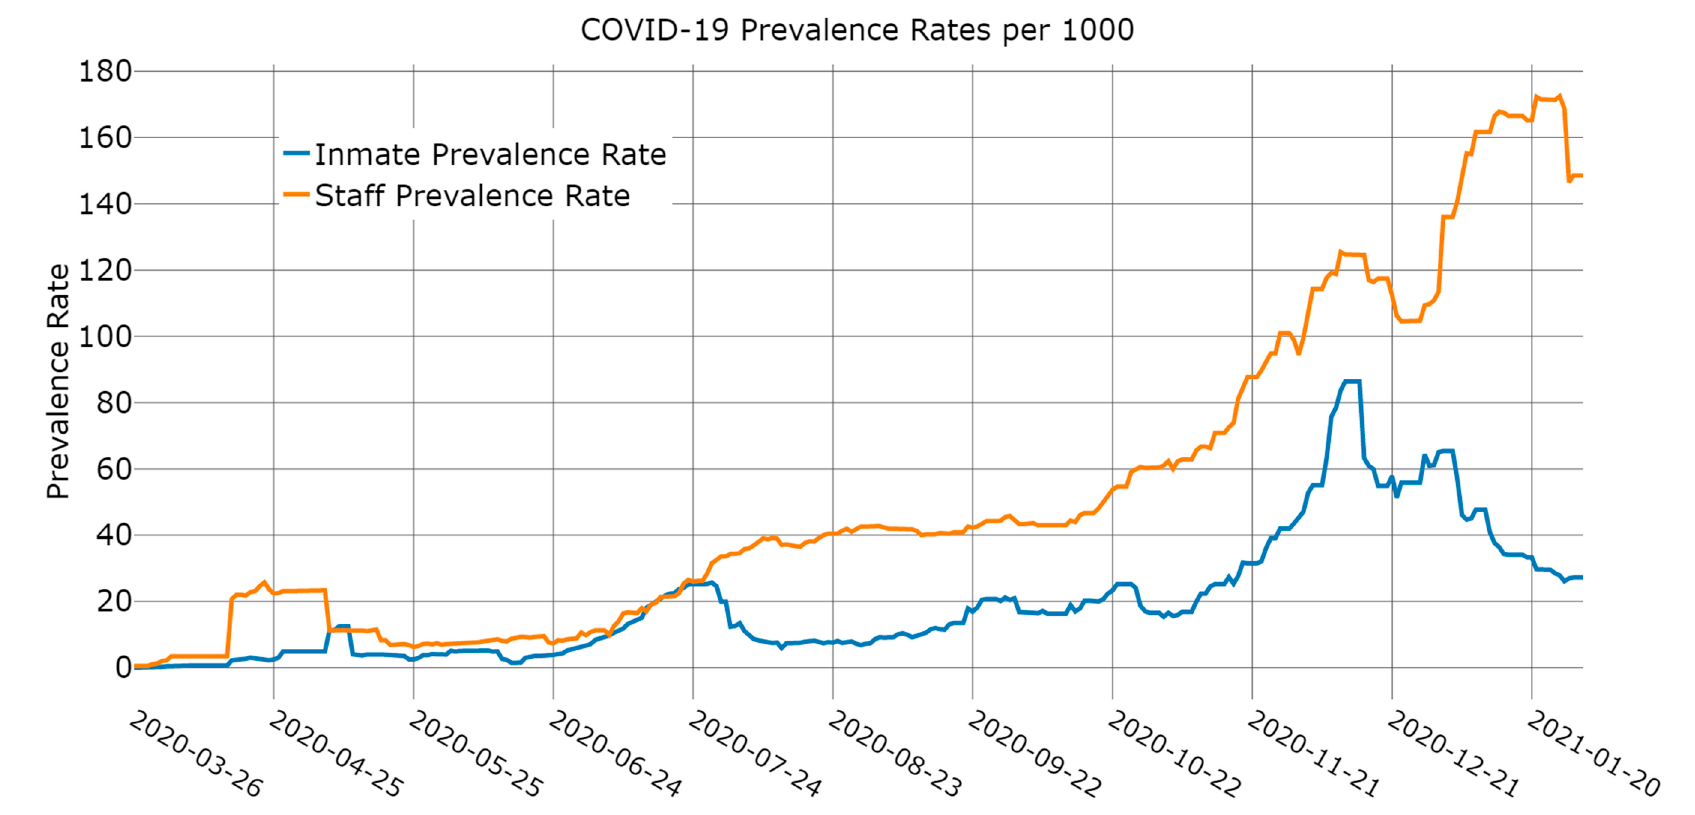
Figure 1. Prevalence rates of COVID-19 infections among staff and incarcerated persons.